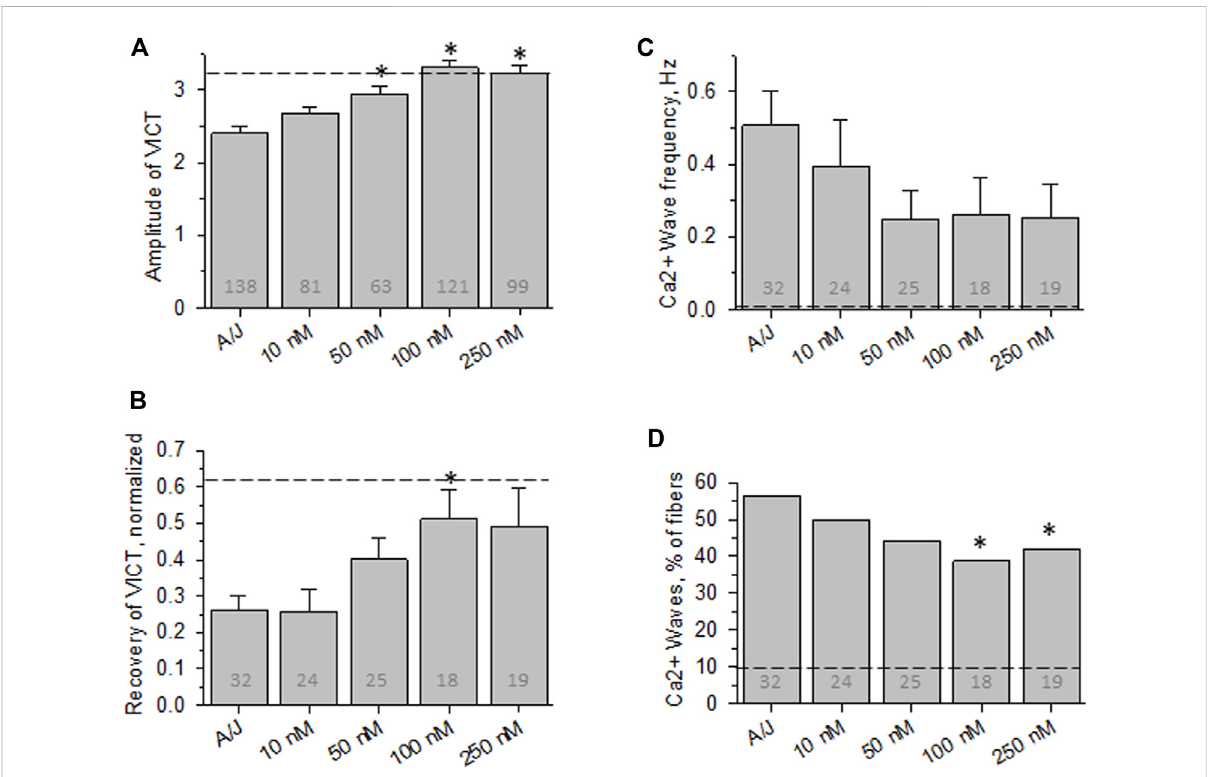
FIGURE 3 Effect of osmotic shock injury on Ca 2+ transients inA/J FDB fi berspreloadedwith different concentrationsof Fluo-4AM.As in Figure 2, but with myo fi bers loaded with Fluo-4AM. (A) , averaged amplitudes of Ca 2+ release before OSI presented as (F max -F 0 )/F 0 . (B) , averaged data for recovery of Ca 2+ transients at 5 min after OSI. (C) , averaged data for frequency of Ca 2+ waves at 5 min after OSI. (D) , % fi bers that produced Ca 2+ waves at 5 min after OSI. Dashed lines represent values obtained with A/JCr fi bers. *, p < 0.05 compared to A/J. N is indicated in each bar. Student ’ s t test was used for (A – C) ; Χ 2 was used for (D) . VICT = Voltage-induced Ca 2+